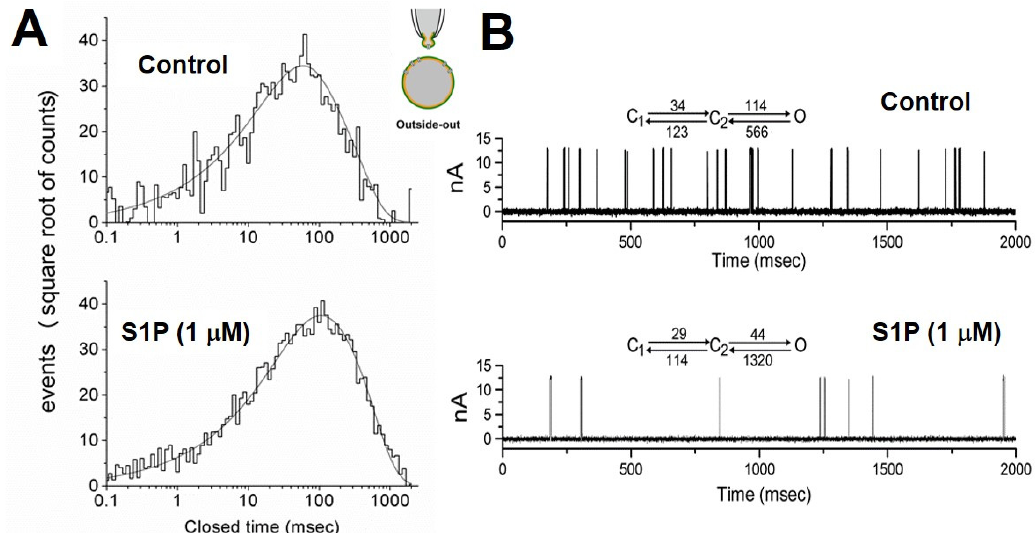
• ) and presence ( ) of (cid:35)